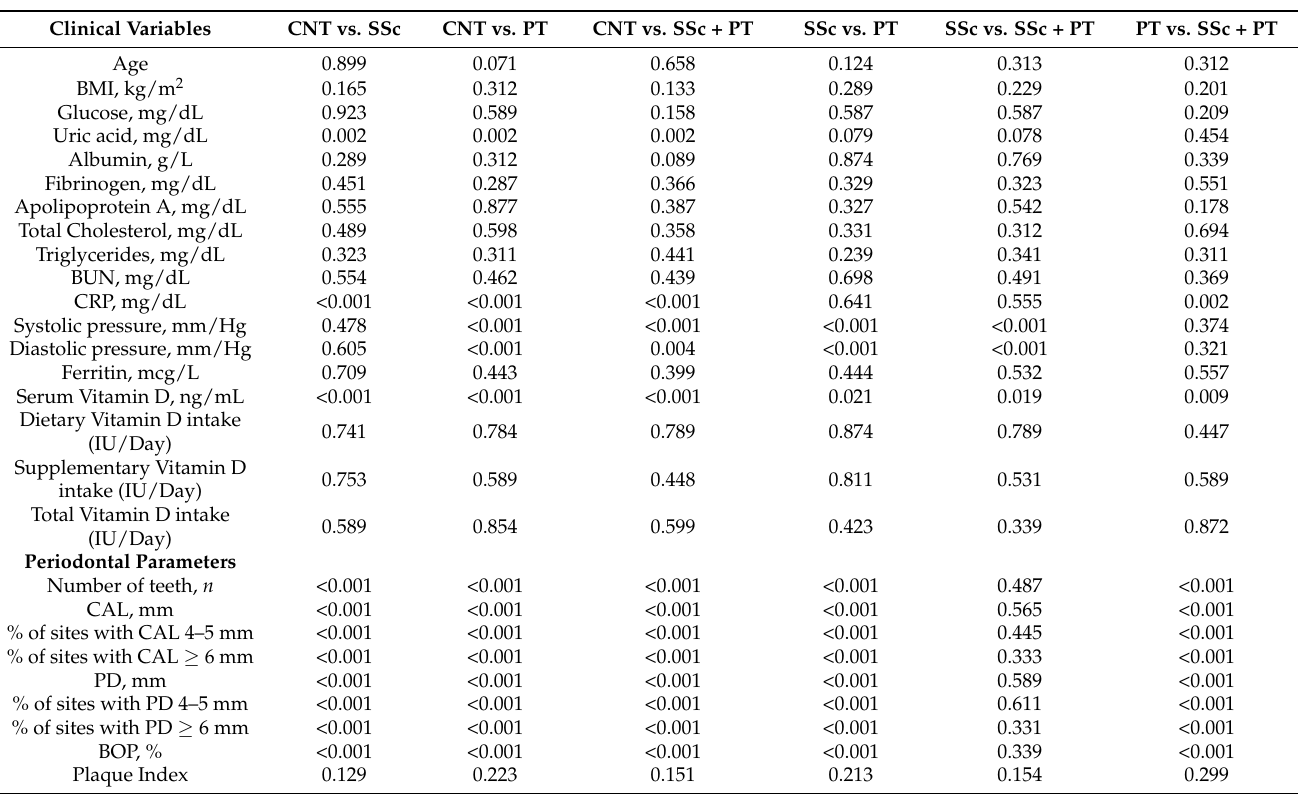
Table 2. p -value of two-by-two comparison between groups performed by the Mann–Whitney test. Adjusted α level = 0.008. Clinical Variables